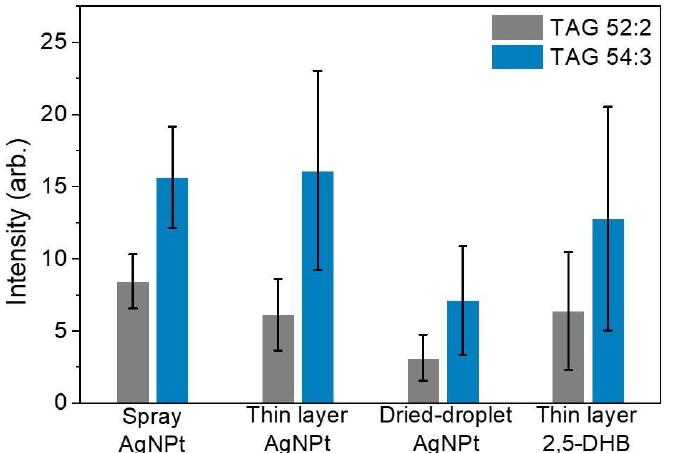
Figure 2. Ion intensity and error bar in the TAG signals obtained using various sample preparations: spray of AgNPt solution (RSD 22.42%), a thin layer of AgNPts (RSD 41.67%), dried droplets of AgNPts (RSD 52.04%), and a thin layer of 2,5-DHB (RSD 62.2%). The signals at m/z 881.7 and 907.7 correspond to [TAG 52:2+Na] + and [TAG 54:3+Na] + , respectively. Each data bar represents the accumulation of 20 laser shots. Error bars represent the standard errors in 5 samples, including 10 spots from each sample and 20 laser shots at each sample spot. The average RSD is calculated using these two TAG signals. Gray bars represent TAG 52:2—RSDs of the TAG 52:2 signal: 22.38% (spray of AgNPt solution), 40.57% (thin layer of AgNPts), 51.15% (dried droplets of AgNPts), and 64.36% (thin layer of 2,5-DHB). Blue bars represent TAG 54:3—RSDs of the TAG 54:3 signal: 22.46% (spray of AgNPt solution), 42.76% (thin layer of AgNPts), 52.93% (dried droplets of AgNPts), and 60.03% (thin layer of 2,5-DHB).